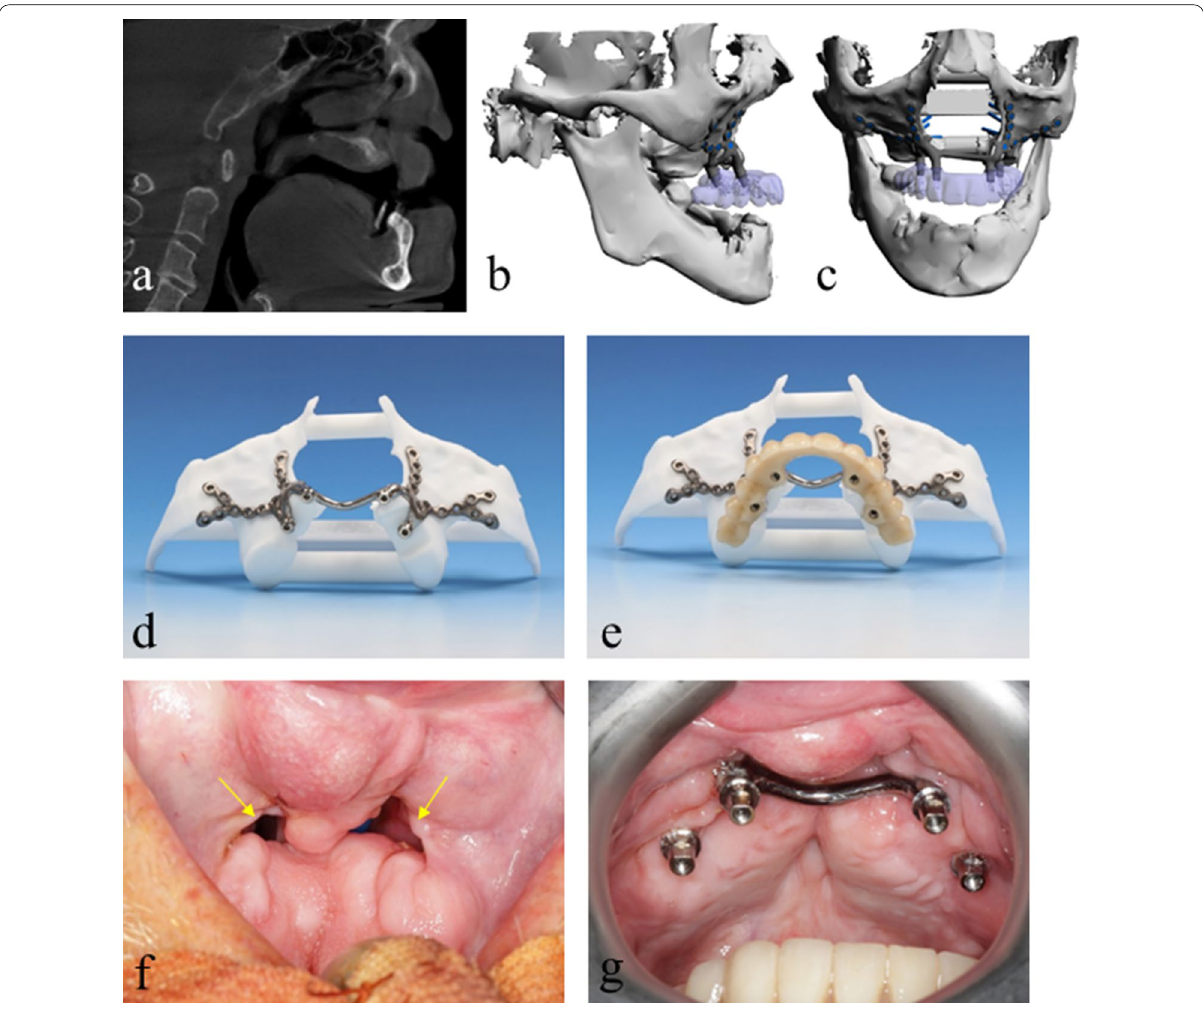
Fig. 1 Radiologic and clinical presentation of a typical patient. Imaging results from a 68‑year‑old patient showing a compromised vertical and sagittal bony dimension in the remaining maxilla together with an extended anterior oronasal fistula. Sagittal screenshot of a cone beam CT showing the distinctive pseudo‑class III relationship ( a ) and the backward planning of the posts considering the opposing arch of the mandible ( b – c ). An IPS‑preprosthetic ® implant mounted on a stereolithography model ( d ) with a temporary denture ( e ). A case of significant bony defect within an extended oronasal fistula in the anterior maxilla prior to implant‑borne dental rehabilitation ( f ) and the following IPS‑preprosthetic ® placement where the connecting palatal bar bridges the anterior maxillary defect, which was digitally preplanned ( g